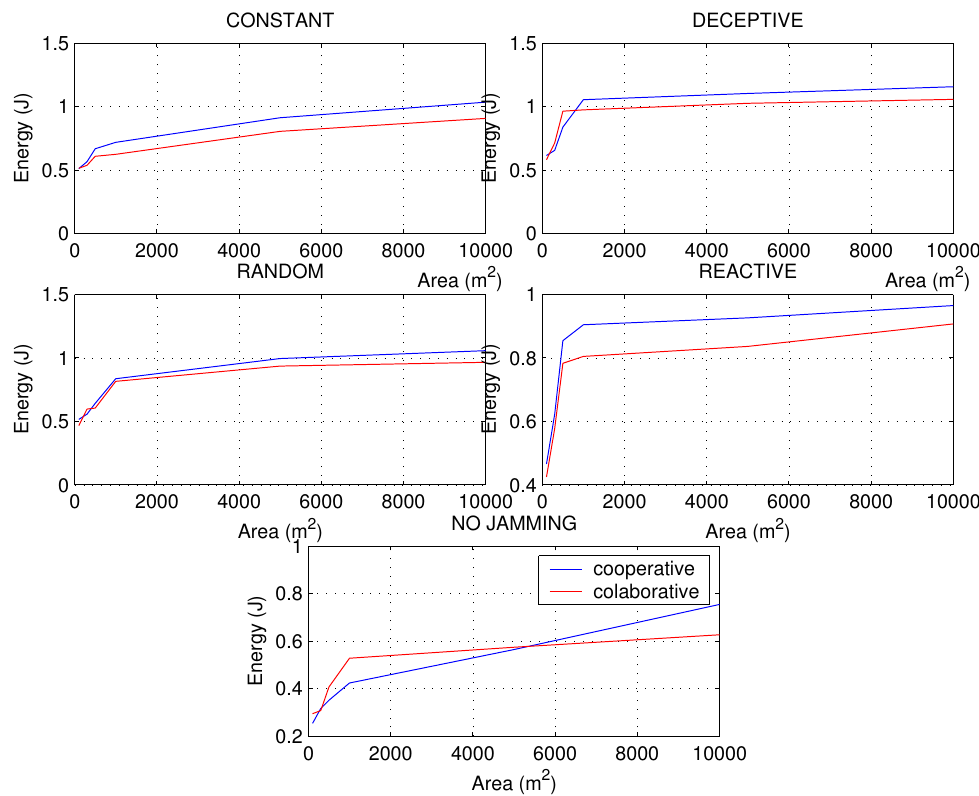
Figure 13. Energy for types of jamming in a WSN of 200 nodes with different areas under collaborative and cooperative